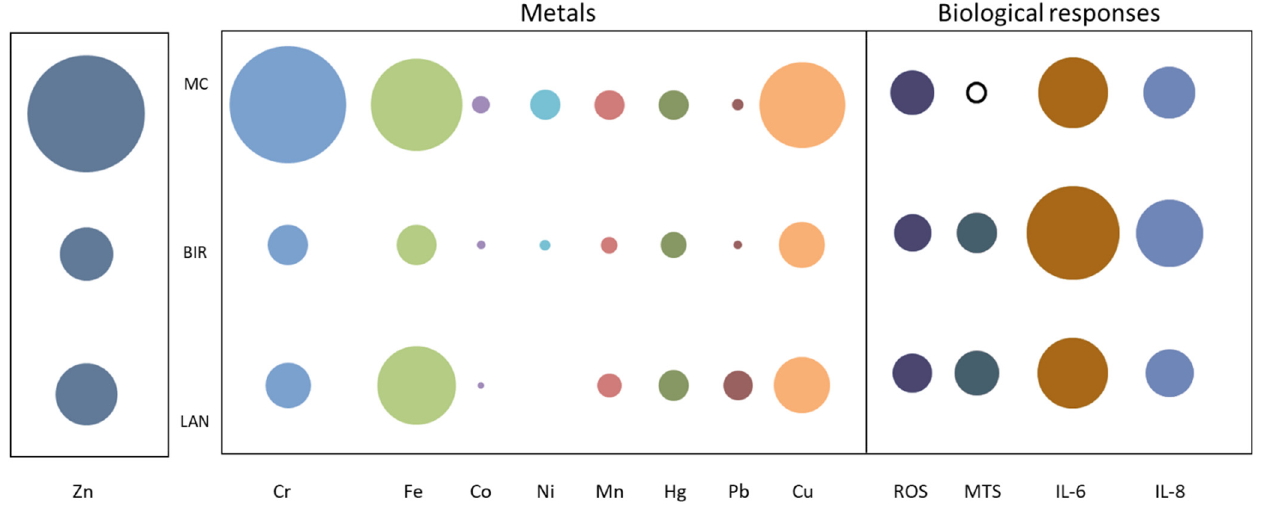
Figure 6. Summary of biological responses and heavy metal concentrations of UF-RDPs from Lan- caster, Birmingham, and Mexico City in Calu-3 cells. The bubble plot depicts the relative abundance of selected metals (ppm) in UF-RDPs from Mexico City (MC), Birmingham (BIR), and Lancaster (LAN). The concentration of Zn is ~10-fold greater than the other metals so has been scaled separately. The biological responses to 75 µg/mL UF-RDPs are represented as percentages of the untreated control, measured at 24 h (MTS, IL-6, and IL-8) or 4 h (ROS). Solid black outline indicates a decrease, whilst filled circles indicate increases.